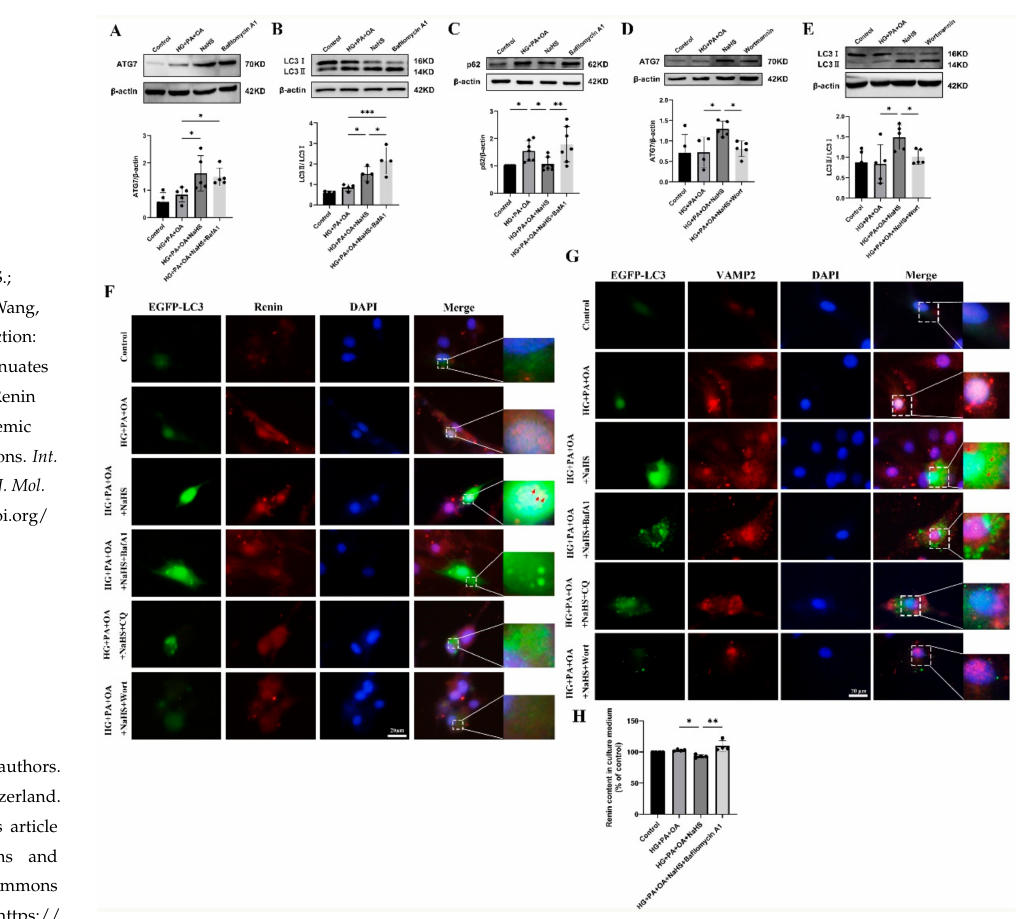
Figure 6. Exogenous H 2 S promoted renin consumption through activation of autophagy. ( A – E ) The expression levels of ATG7, LC3II/I and p62 were detected by Western blotting after treatment